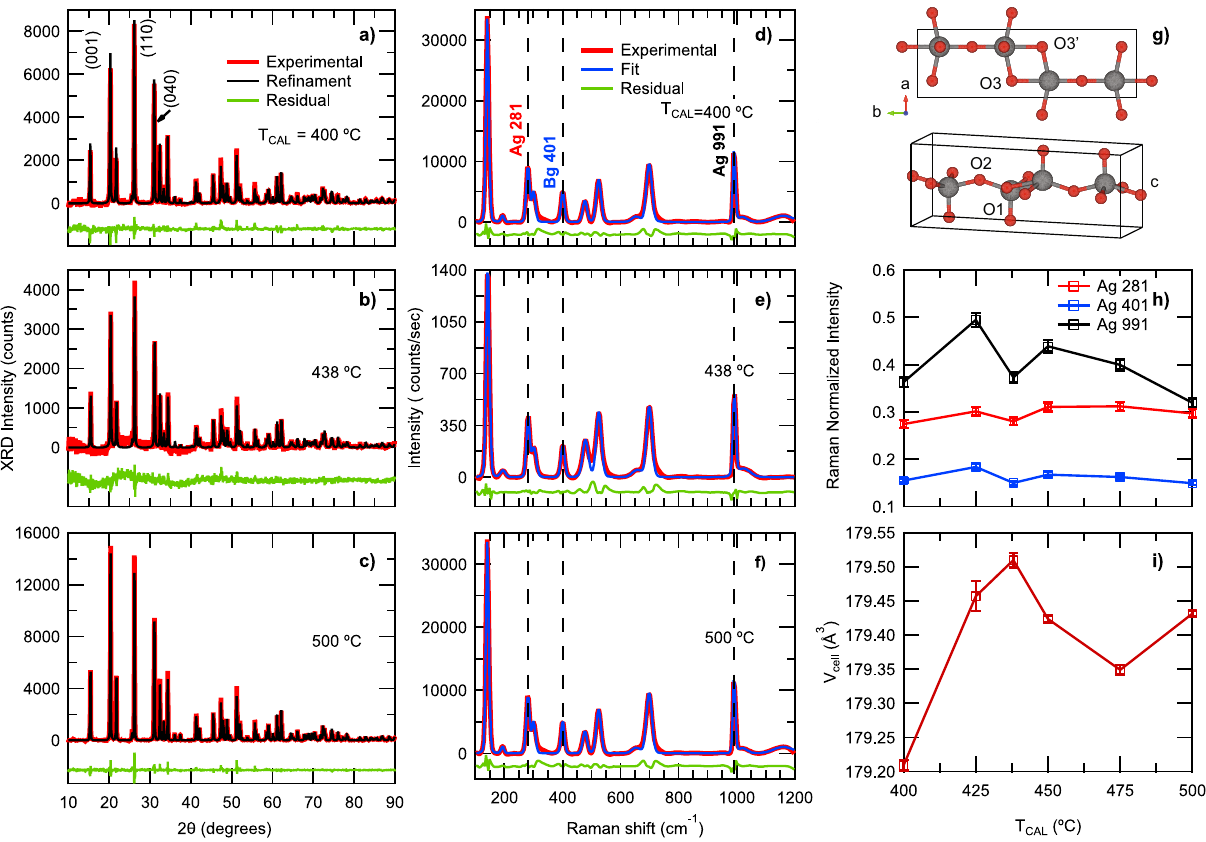
Figure 1. X-ray diffraction patterns of representative samples. T CAL = ( a ) 400 °C, ( b ) 438 °C, and ( c ) 500 °C. All the X-ray diffraction peaks coincide with those reported for α-V 2 O 5 . Raman spectra for samples at T CAL = ( d ) 400 °C, ( e ) 438 °C, and ( f ) 500 °C. The Raman peaks correspond to those ascribed to α-V 2 O 5 . The ( d ) panel indicates three Raman modes A g or B g with their positions in cm -1 that are associated with vanadyl oxygens O1. ( g ) The orthorhombic unit cell of V 2 O 5 with vanadium atoms in grey and oxygen atoms in red. ( h ) Selected normalized Raman intensities as functions of T CAL . These normalized Raman intensities were calculated by dividing by the maximum intensity at 142 cm −1 . The error bars were estimated by calculating the standard deviation from several measurements using the mode at 281 cm −1 for 450 °C as a reference. ( i ) Unit cell